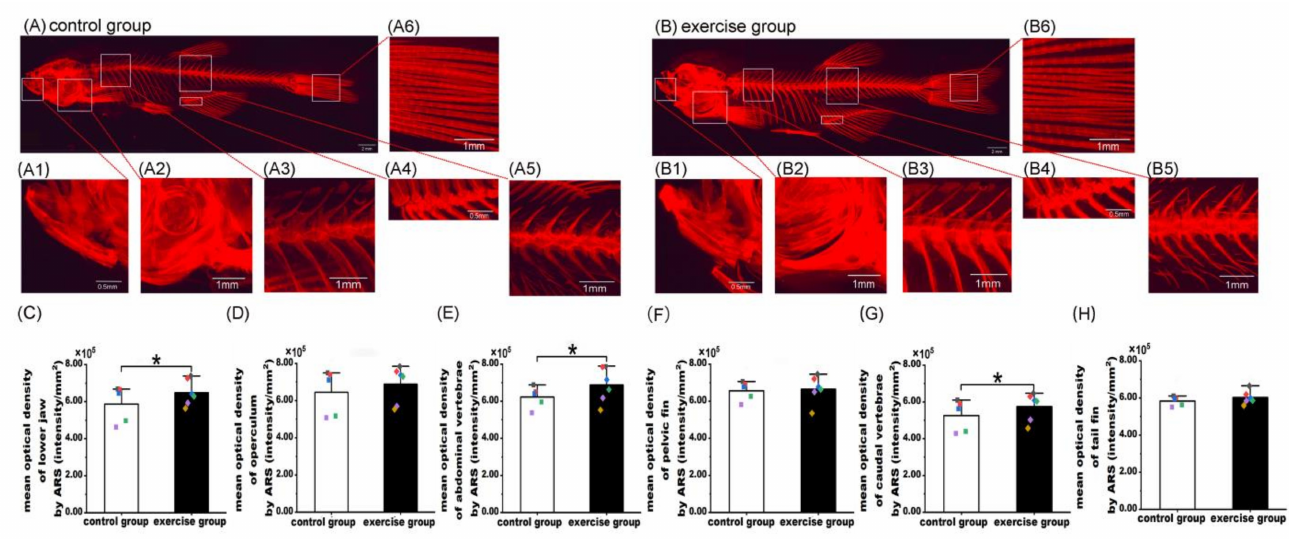
Figure 1. Alizarin red S (ARS) staining of bone tissue and quantification of bone mineralization in the control and exercise groups. Fluorescent image of ARS staining of zebrafish to visualize the whole-body skeleton of the control ( A ) and exercise ( B ) groups. Magnified fluorescent images of the lower jaw ( A1 , B1 ), operculum ( A2 , B2 ), abdominal vertebrae ( A3 , B3 ), pelvic fin ( A4 , B4 ), caudal vertebrae ( A5 , B5 ), and tail fin ( A6 , B6 ). Comparison of mean optical density in the lower jaw ( C ), operculum ( D ), abdominal vertebrae ( E ), pelvic fin ( F ), caudal vertebrae ( G ), and tail fin ( H ) between the exercise and control groups. The values of mean optical density are expressed as mean and standard deviation. A mixed linear model containing both fixed effects (e.g., intervention method) and random effects (e.g., photographing time) was used to evaluate the impact of exercise on bone mineralization in the lower jaw, operculum, abdominal vertebrae, pelvic fin, caudal vertebrae, and tail fin. The black, red, blue, green, and purple squares represent the control group fish numbers 13, 14, 15, 16, and 17, respectively. The black, red, blue, green, purple, and yellow diamonds represent exercise group fish numbers 14, 15, 16, 17, 18, and 19, respectively. *, p <